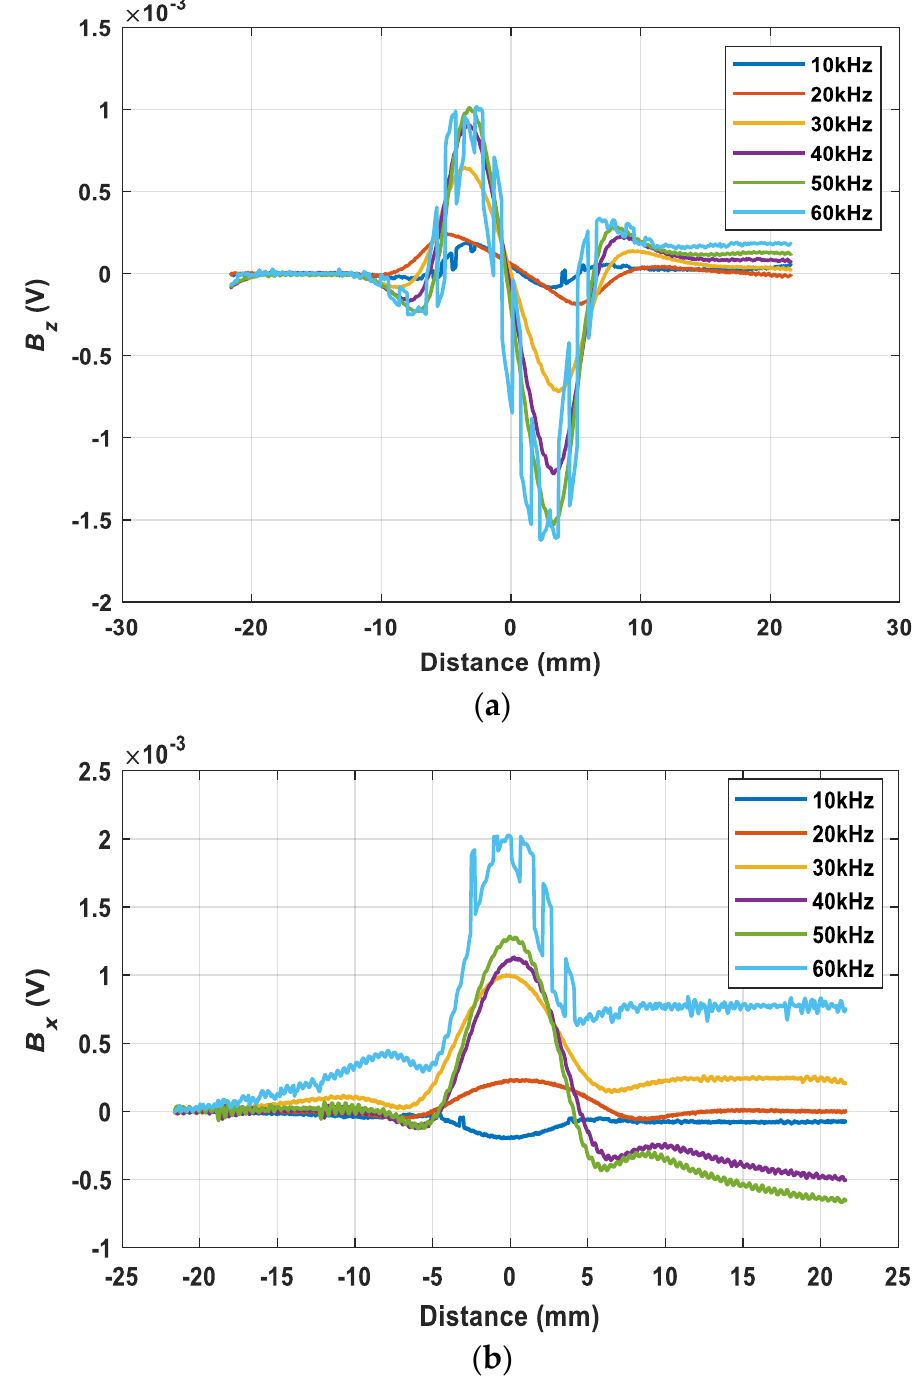
Figure 10. The voltage received from the sensor probe under different frequencies ( a ) 𝑩